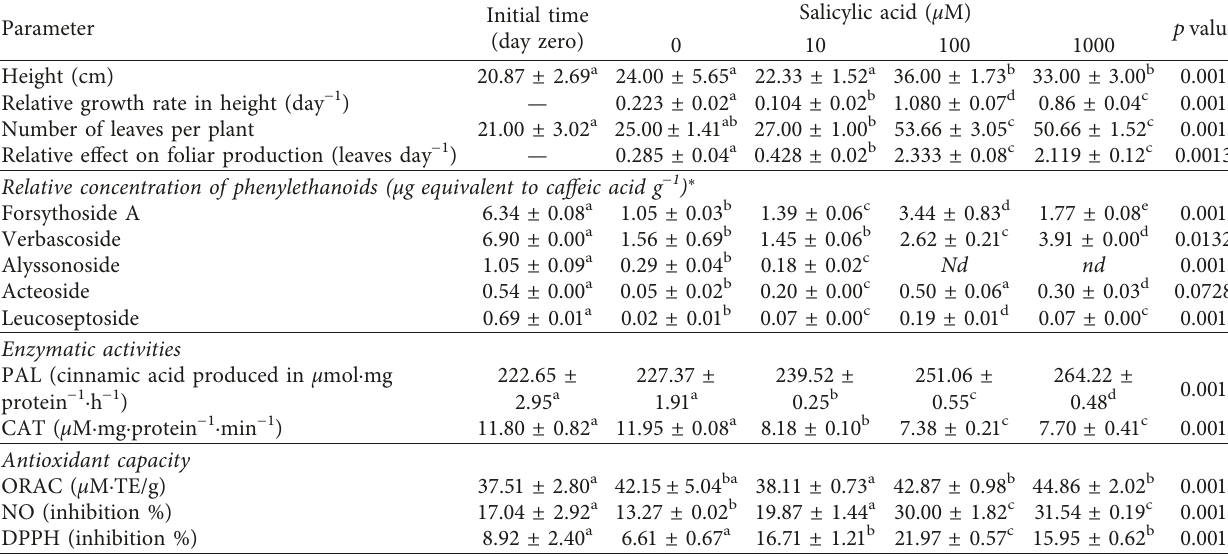
Table 1: Effect of different salicylic acid concentrations on growth parameter, phenylpropanoids biosynthesis, enzymatic activities, and antioxidant capacity in a period of 14 days at 25 ° C.